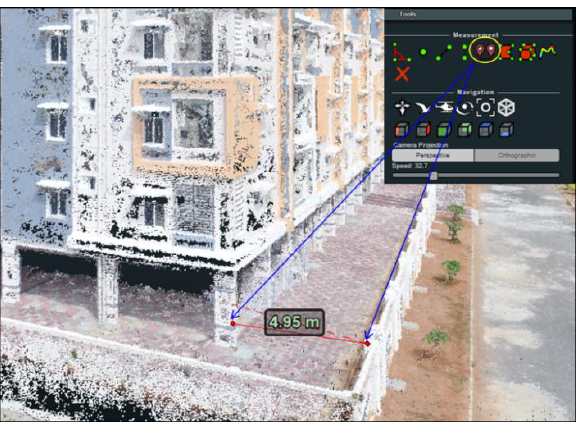
Table 1: Building 1 measurements derived from Drone